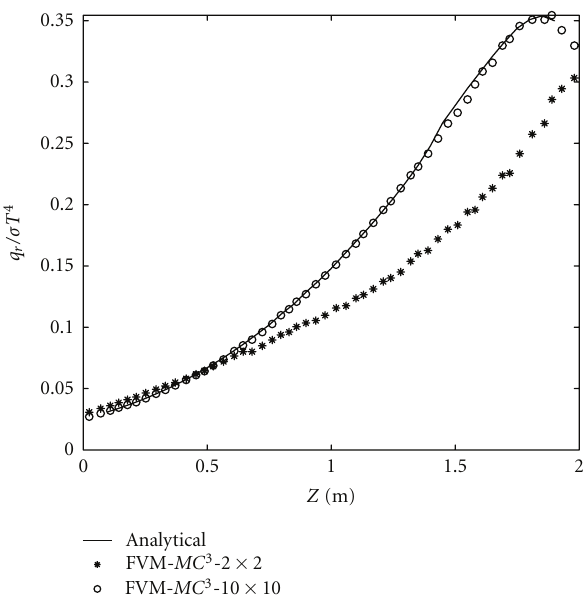
Figure 4: Results for test case II.